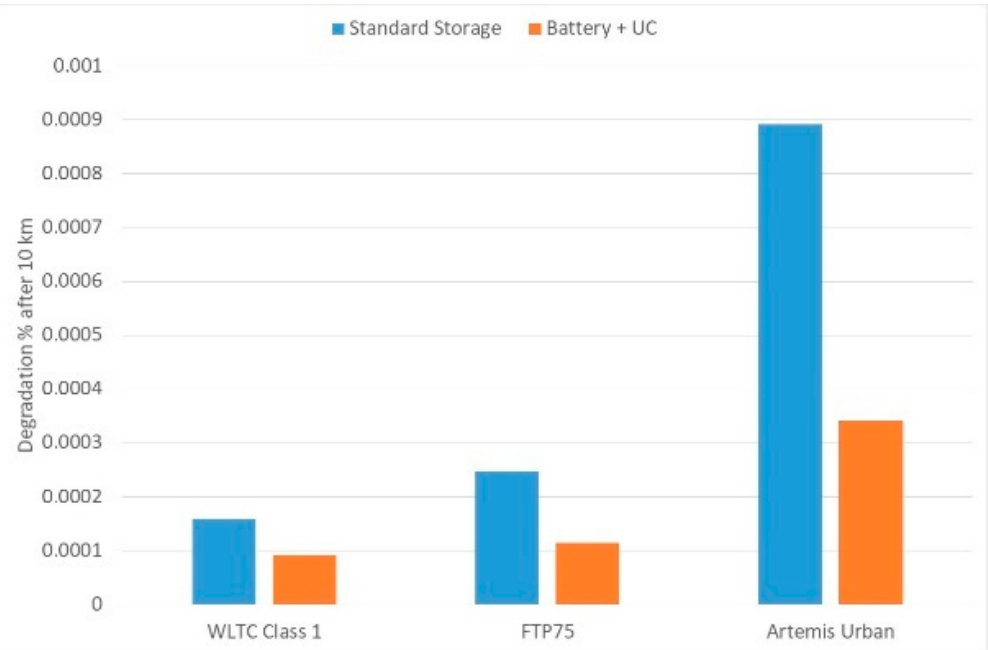
Figure 18. Absolute degradation for different driving cycles after 10 km, with and without UCs.